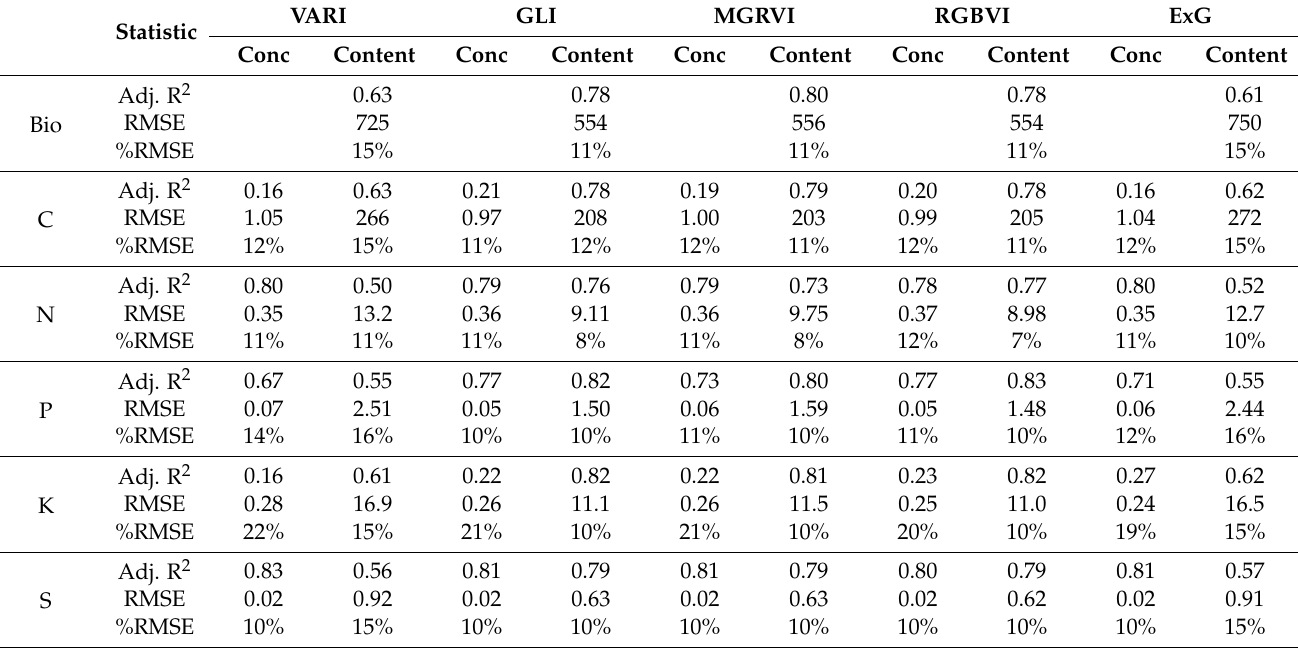
Table 7. Root mean square error (RMSE), %RMSE, and coefficient of determination (R 2 ) for repeated K-fold cross validation of concentration (conc) and content-based cereal rye biomass (Bio) and nutrient accumulation models for different vegetation indices developed using the complex